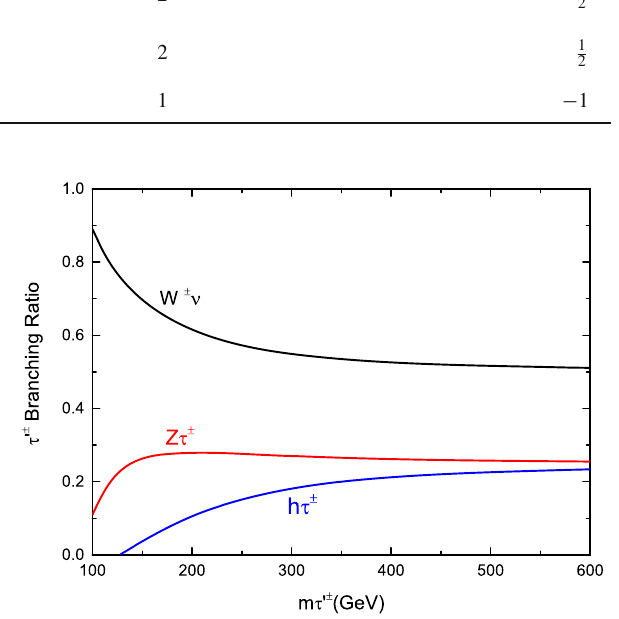
Fig. 1 The branching ratios of τ (cid:2)± as a function of m τ